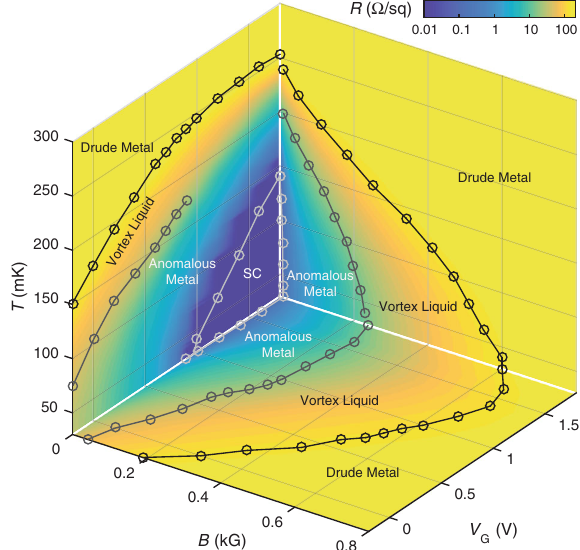
Fig. 4 Global phase diagram in the ( V G , B , T ) parameter space. Transitions/crossovers points are de fi ned by methods discussed in the main text. Note that on the ( V G , B ) and ( B , T ) planes, the superconducting (SC) regime has a very small experimental width along the B axis. The color scale in the background shows the interpolated resistivity. All data in this fi gure are from Sample